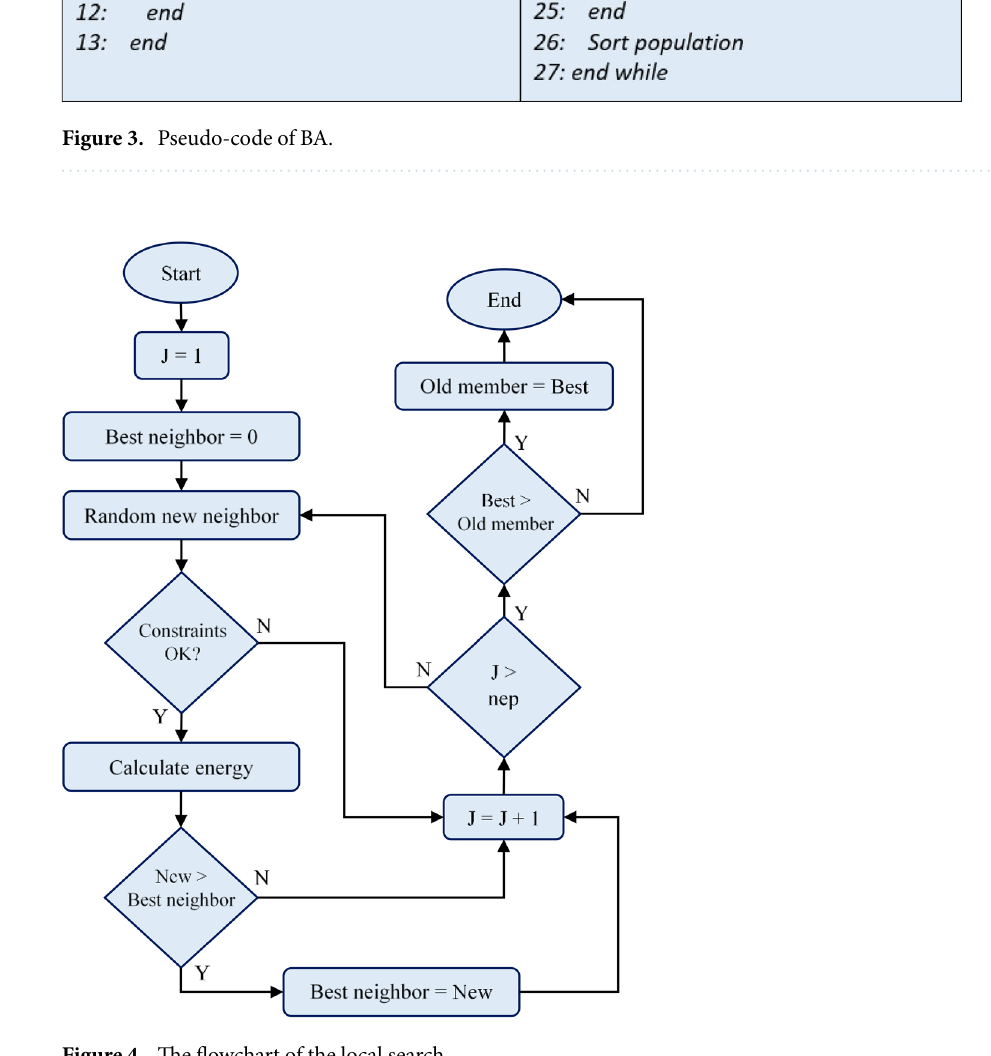
Figure 4. The flowchart of the local